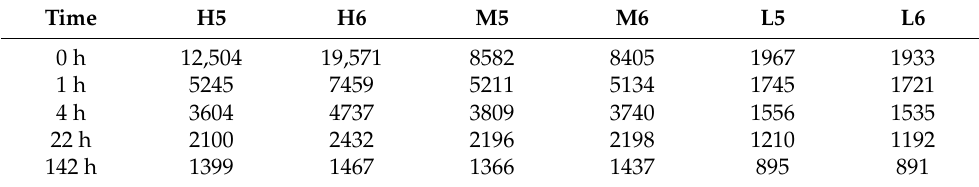
Table 5. Changes of Q-factor of different samples under high-temperature baking at 125 ◦ C.